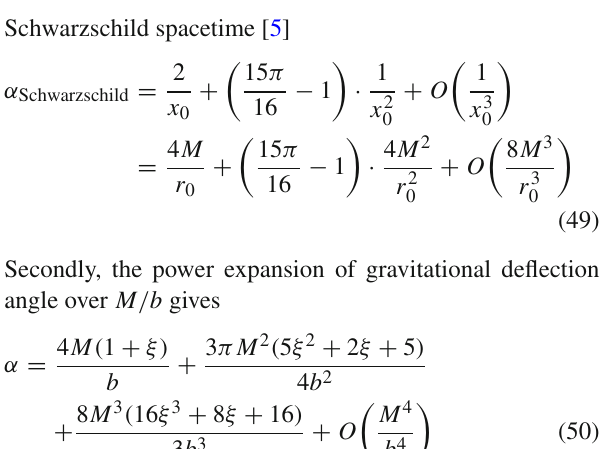
Eq. (27) and hyper-elliptical integral in Eq. (42) are displayed. In right panel, the gravitational deflection angles are plotted with respective to the minimal distance r 0 in the particle orbit r (γ) . Since the gravitational deflection angle obtained from Gauss–Bonnet theorem is a power series of M / b rather than 1 / x 0 = 2 M / r 0 , so we only plot the deflection angle obtained from the hyper-elliptical integral in Eq. (42) in the right